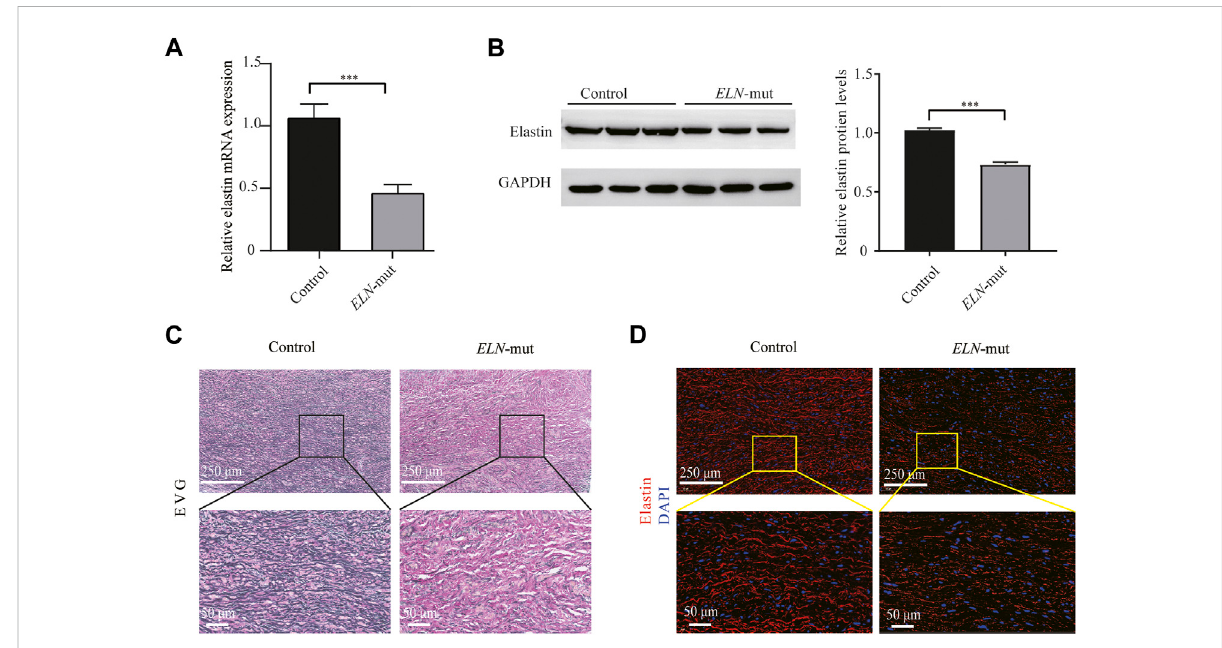
FIGURE 3 Expression analysis of ELN gene in aortic tissues. (A) Expression levels of ELN mRNA in the ELN -mut patients ’ aortic tissue. (B) Elastin levels in aortic tissue of patients. (C,D) EVG stain and immuno fl uorescence of arterial tissues. Tissue samples were obtained from three normal subjects and three probands (from families A, B, and I) with severe SVAS, and statistical methods were performed using student ’ s t -test. ***, p <